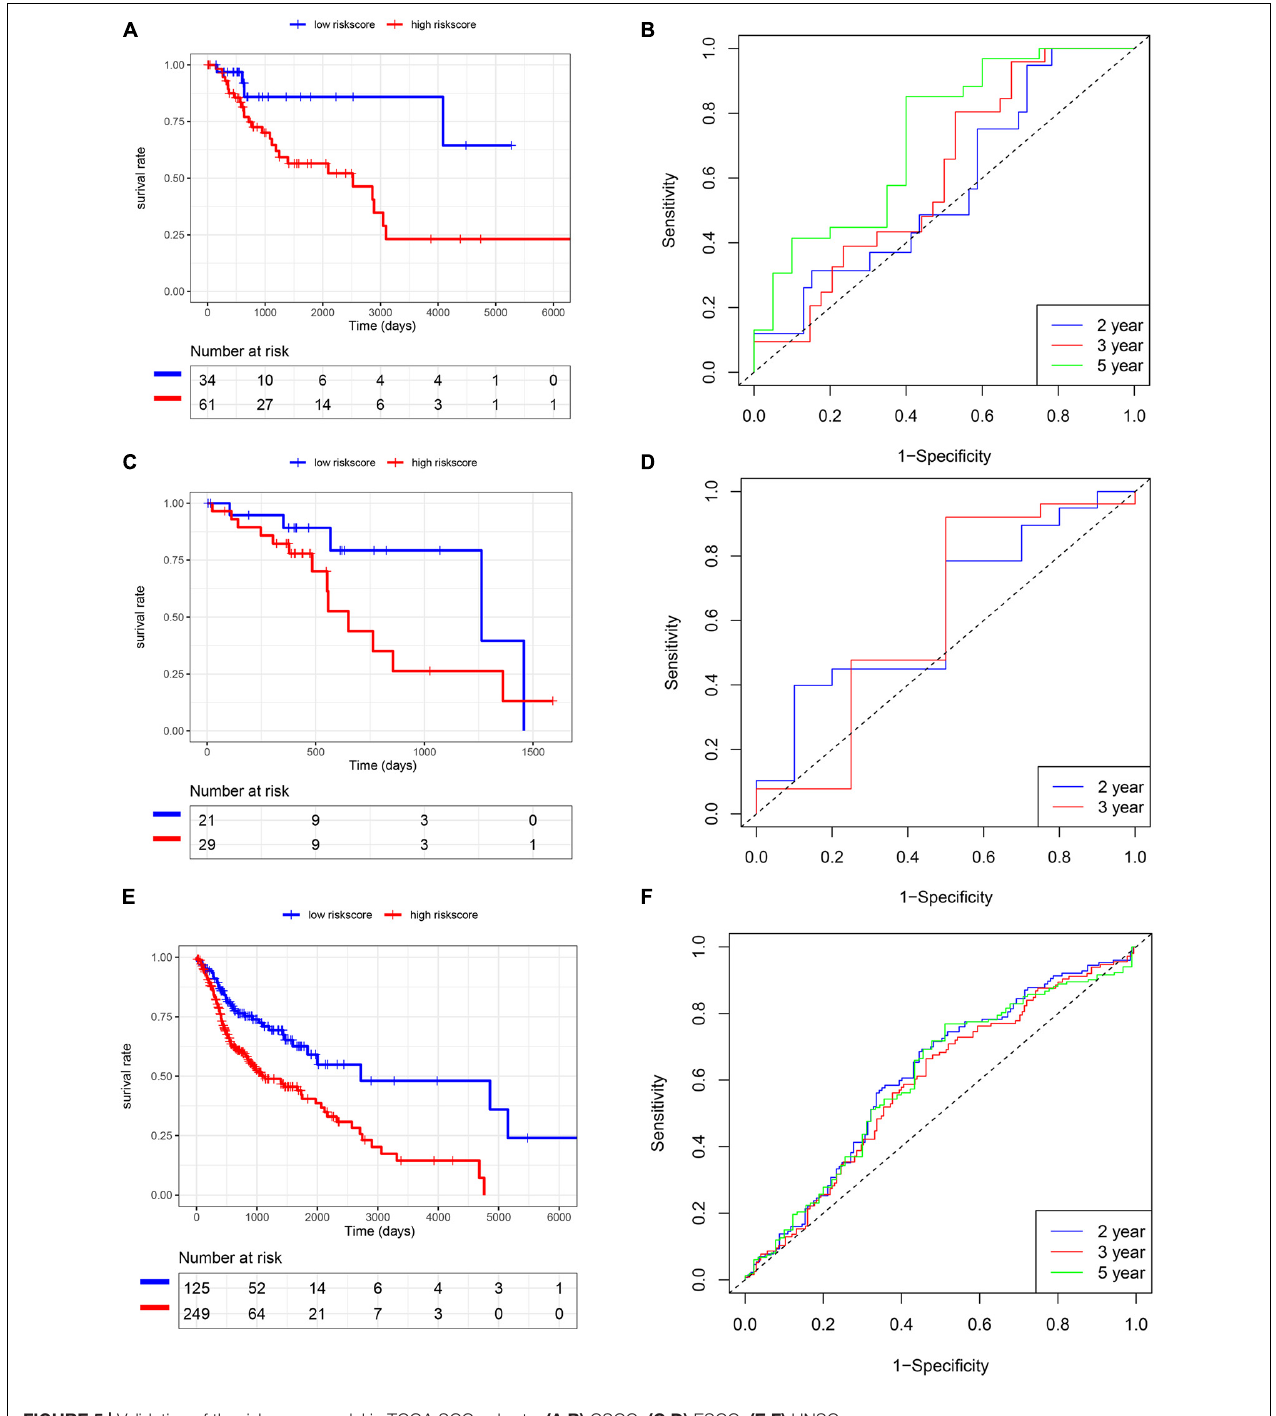
FIGURE 5 | Validation of the risk score model in TCGA SCC cohorts. (A,B) CSCC. (C,D) ESCC. (E,F)